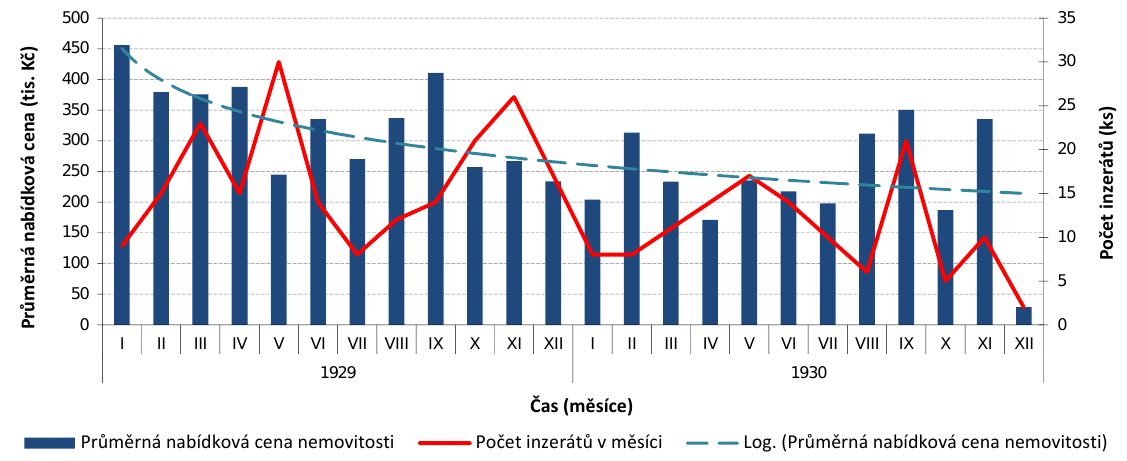
Obrázek 5: Průměrná nabídková cena a počet inzerátů pro rodinný dům v Praze (měsíční data). Data je možné prezentovat i v jiné formě a to pomocí ročních diferencí (Tabulka 45). Výsledky indikují,